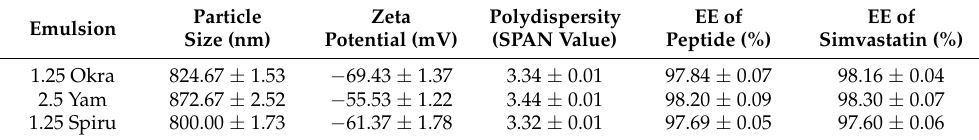
Table 1. The particle size, zeta potential, SPAN, and encapsulation efficiency of the emulsions.